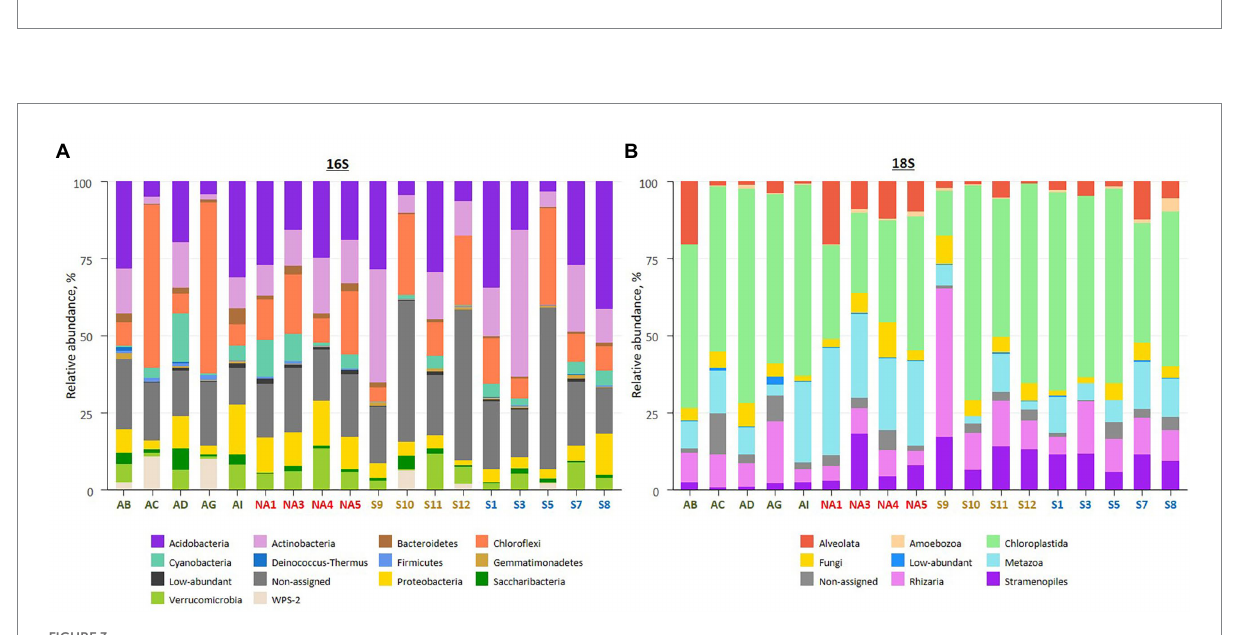
FIGURE 3 Overview on biocrust microbial community composition in the studied localities based on relative abundances of bacterial phyla (A) , and eukaryotic clades (B) . The samples colour codes: green – Iceland, red – Ny-Ålesund, brown – Longyearbyen, blue – South Svalbard. Low- abundant combines phyla or clades with relative abundance <0.5%. Each bar represents an average of